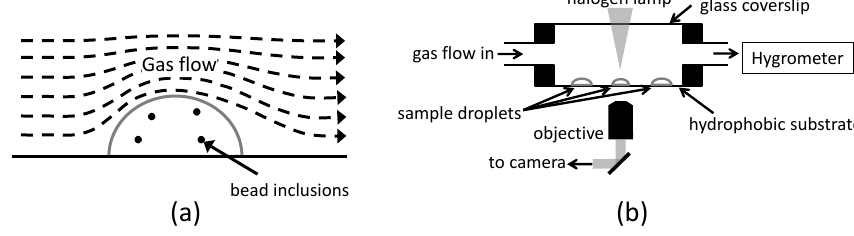
Fig. 2. (a) Illustration of flow around a sample particle. (b) Schematic of instrumental setup where the hydrophobic substrate was either siliconized glass or Teflon. The gas flow was N 2 , either introduced as a dry flow or as a humidified flow. Table 1. Types of material studied as well as the molecular formula, molecular weight (MW), oxygen-to-carbon (O:C) atomic ratio and viscosity (20 ◦ C) of the material. The materials have been arranged by increasing O:C ratio. Particle material Range of Molecular formula of MW of O:C of Range of References for